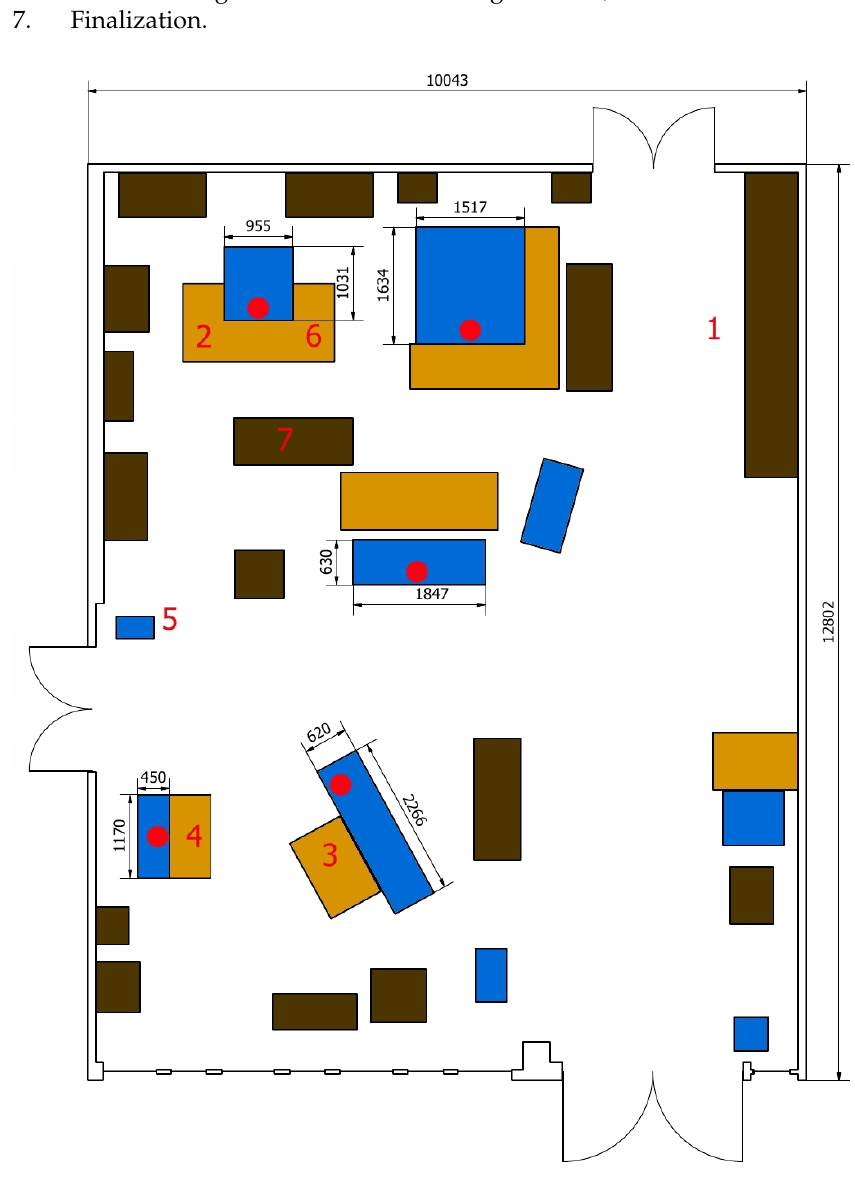
Figure 6. The laboratory layout, where the blue rectangles denote the machines, the red circles stand for the reference points (on the machines) with regard to the IPS, and the numbers represent the production